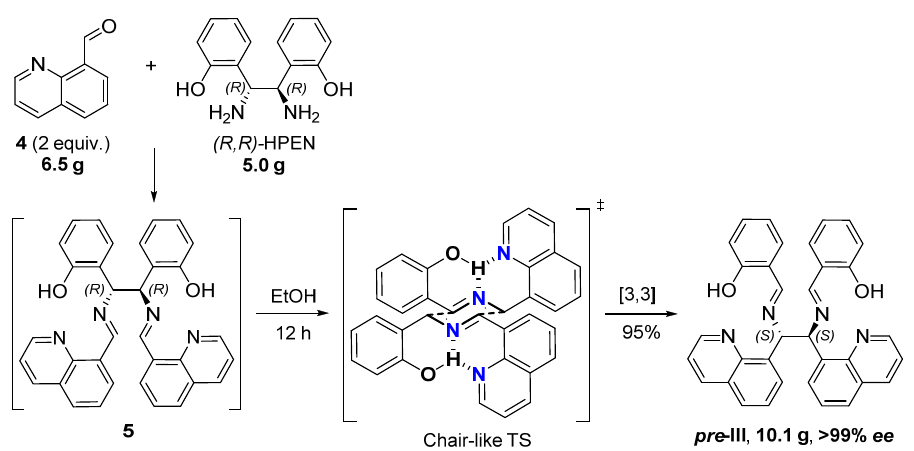
Figure 2. Stereoselective synthesis of pre -III from 8-quinolinecarbaldehyde ( 4 ) and ( R,R )-HPEN via the diaza-Cope rearrangement.